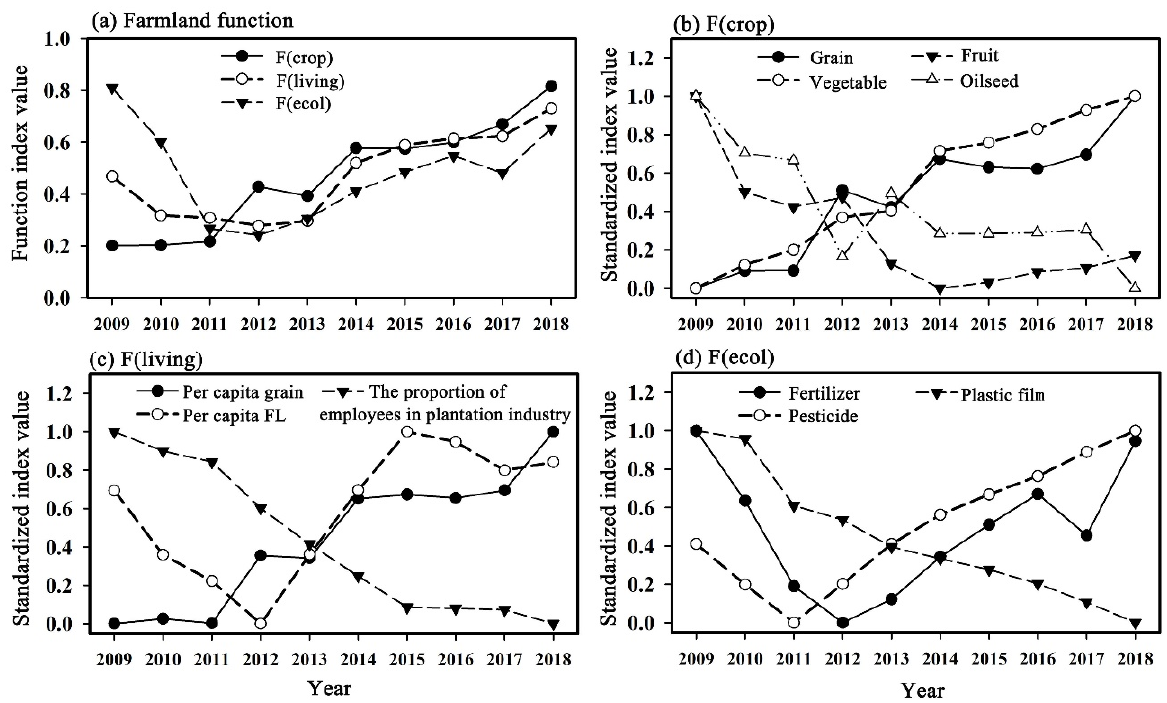
Figure 7. Changes in the farmland function in Sihong from 2009 to 2018.